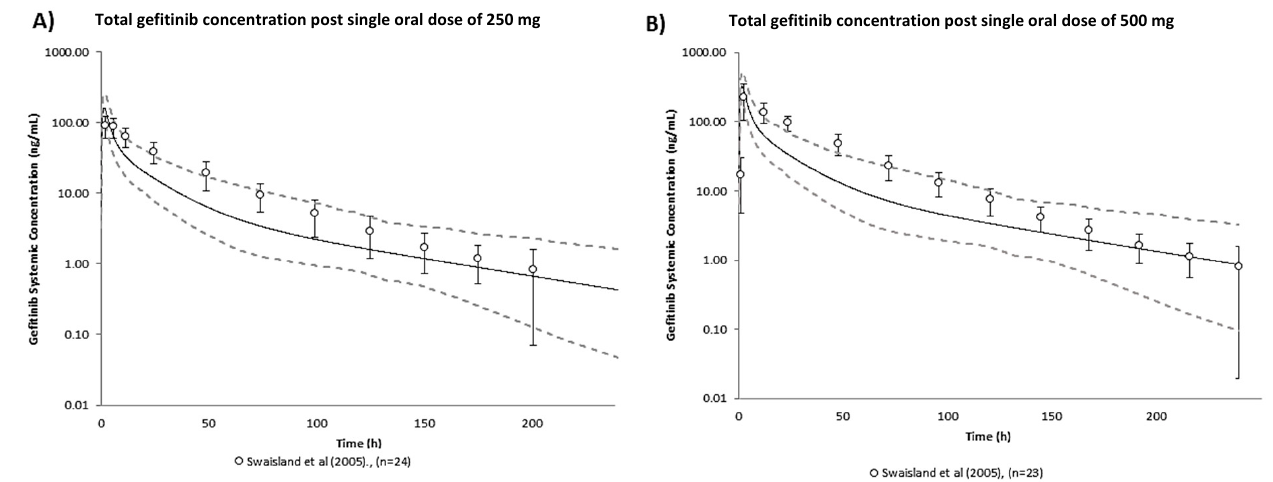
Figure 1. Verification of the gefitinib human PBPK model: predicted geometric mean (solid black line) and observed geometric mean (data points) ± standard deviation (error bars) of total gefitinib concentration post single oral dose of ( A ) 250 mg and ( B ) 500 mg [27]. The dashed lines refer to the predicted 95th percentile range. Virtual population demographic was simulated to be equivalent to the reported study (healthy volunteers, aged 21–57 years old, 0% female, n = 100).